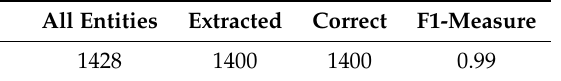
Table 8. Evaluation of car entity extraction on the test set.